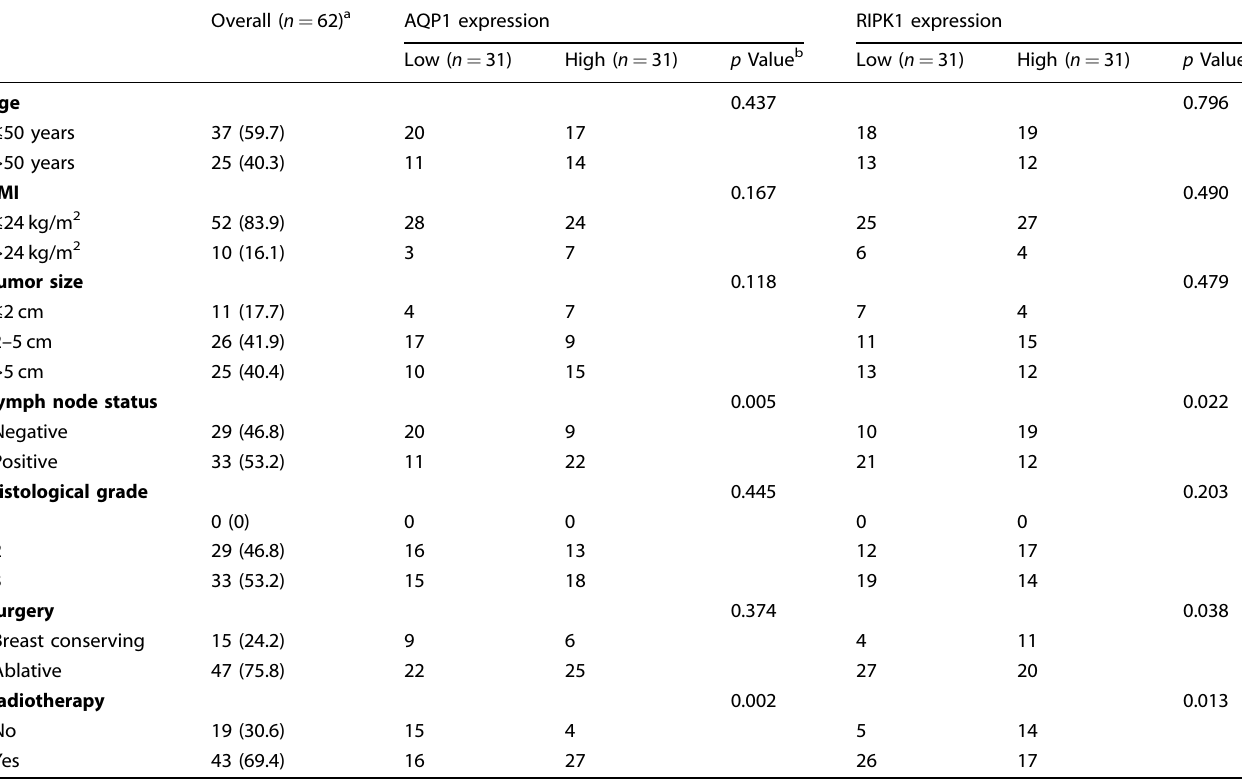
Table 1. Frequency and distribution of AQP1 expression in association with established sociodemographic and oncological features of TNBC